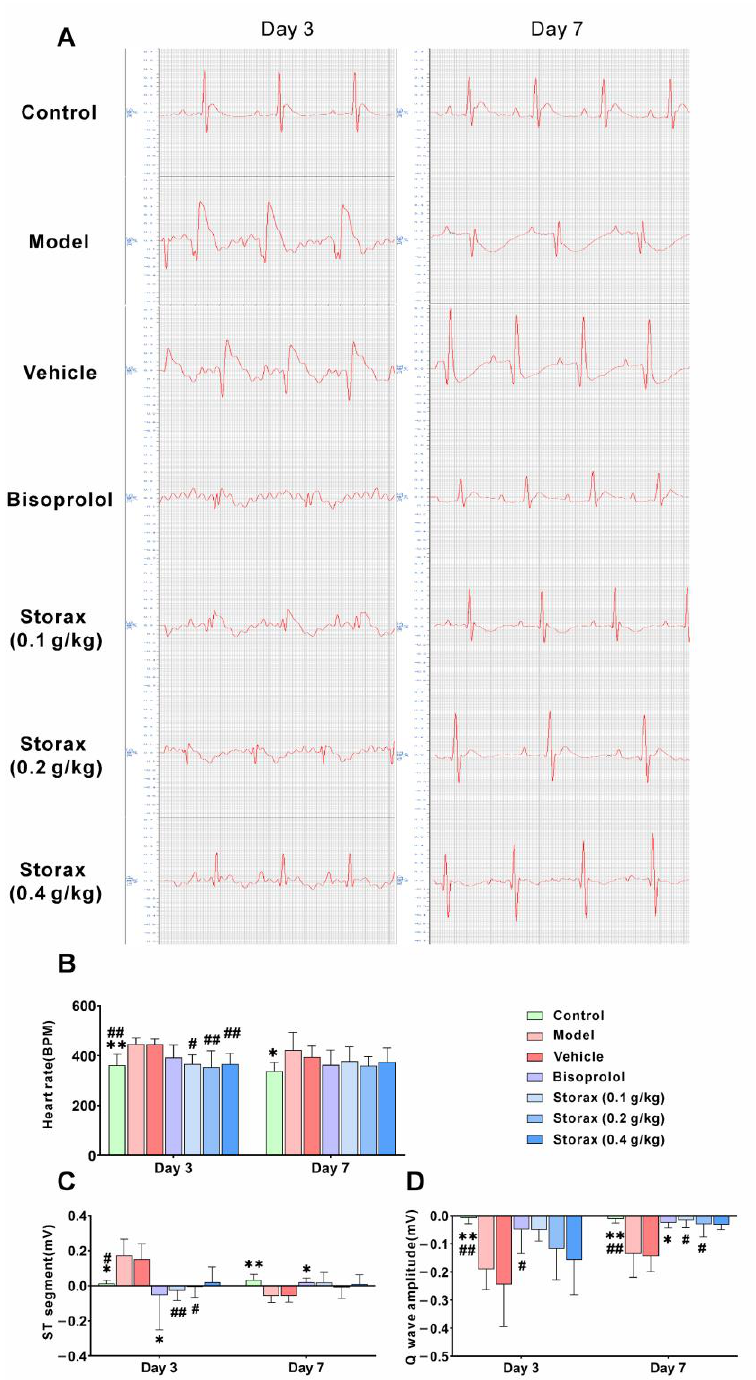
Figure 2. Effect of storax on the electrocardiogram of Isoproterenol hydrochloride (ISO)-induced acute myocardial infarction (AMI) rats. ( A ) Representative images of electrocardiogram. ( B ) Heart rate (HR). ( C ) ST-segment amplitude. ( D ) Q-wave amplitude. Results are presented as mean ± SD (n = 8). One-way ANOVA followed by Bonferroni’s post hoc test: * p < 0.05, ** p < 0.01 vs. model group; # p < 0.05, ## p < 0.01 vs. vehicle group.